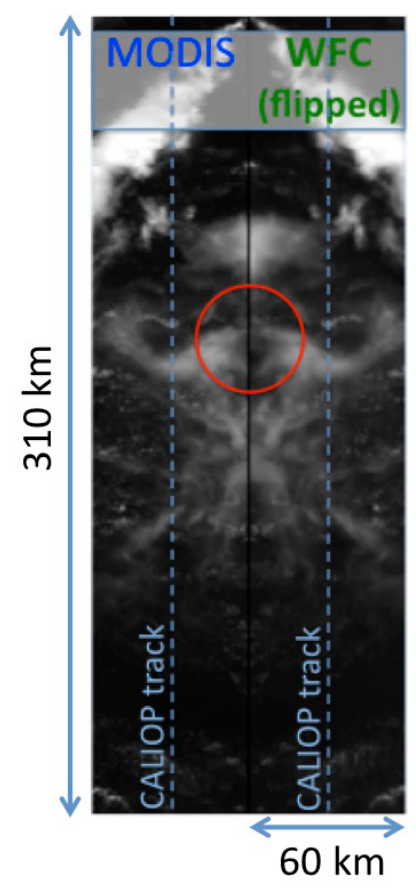
Fig. 1. A sample scene of MODIS and WFC 0.65µm reflectances. As the WFC image is flipped, the full image should be symmetric if clouds did not change between the CALIPSO and Aqua overpasses. The asymmetry highlighted by a circle illustrates clouds drifting with the wind.